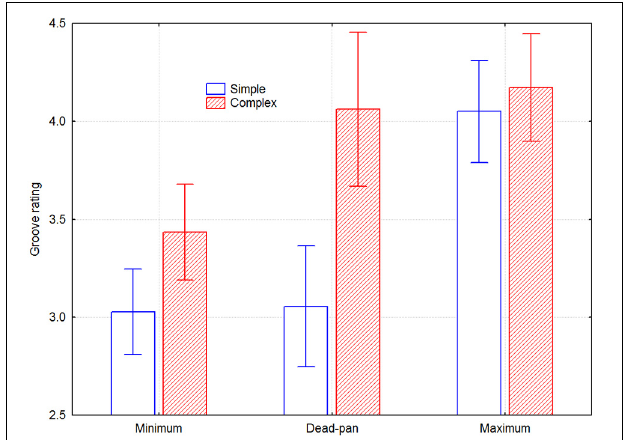
FIGURE 3 | Perceived groove as a function of groove condition and melody type, across listeners. Error bars depict 0.95% confidence